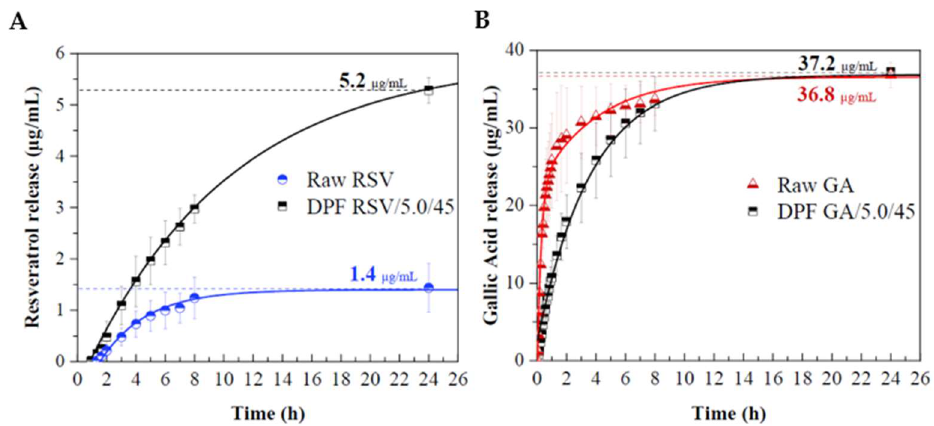
Figure 11. In vitro phenolic release profiles in pH 5.5 PBS at 32 ◦ C for 24 h of ( A ) raw RSV and DPF Figure 11 . In vitro phenolic release profiles in pH 5.5 PBS at 32 °C for 24 h of ( A ) raw RSV and DPF RSV/5.0/45 samples and ( B ) raw GA and DPF GA/5.0/45 samples, expressed in µ g of phenolic RSV/5.0/45 samples and ( B ) raw GA and DPF GA/5.0/45 samples, expressed in µg of phenolic per per mL of mL of solution.